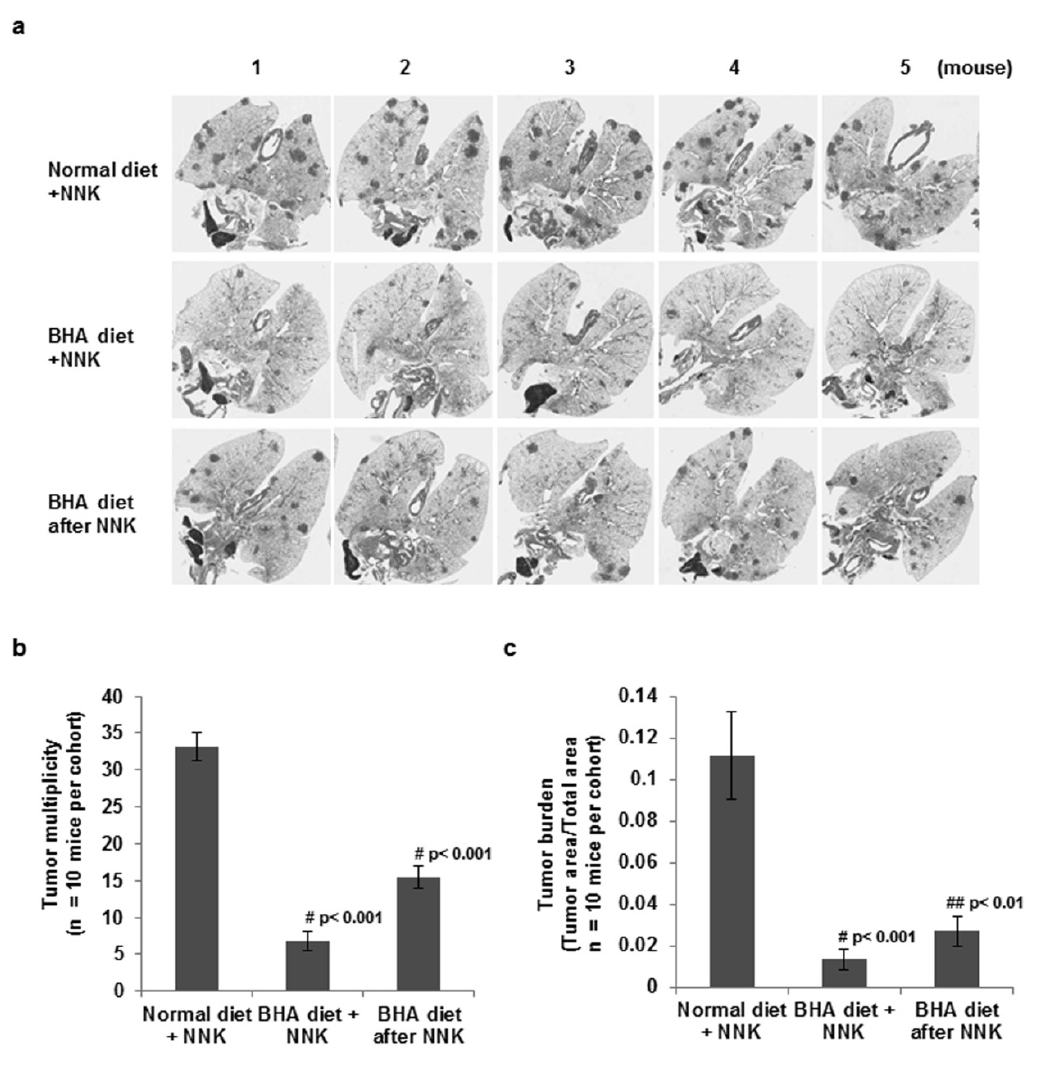
Figure 2. BHA suppresses NNK-induced lung tumorigenesis. ( a ) A/J mice were maintained on normal or BHA diet for 2 weeks prior to NNK injection (Line 1 and 2) or mice on BHA diet 1 week after NNK treatment (Line 3). Lungs were collected at 6 months after NNK treatment and sectioned and stained for H&E. 5 representative H&E images of lungs of mice from each group are shown; ( b ) Lung tumor multiplicity of mice from ( a ) was determined by counting total tumor foci in 5 serial sections at 400 mm intervals; ( c ) Lung tumor burden of mice from ( a ) was shown by the ratio of lung tumor area to total lung are. N = 10; Error Bars: